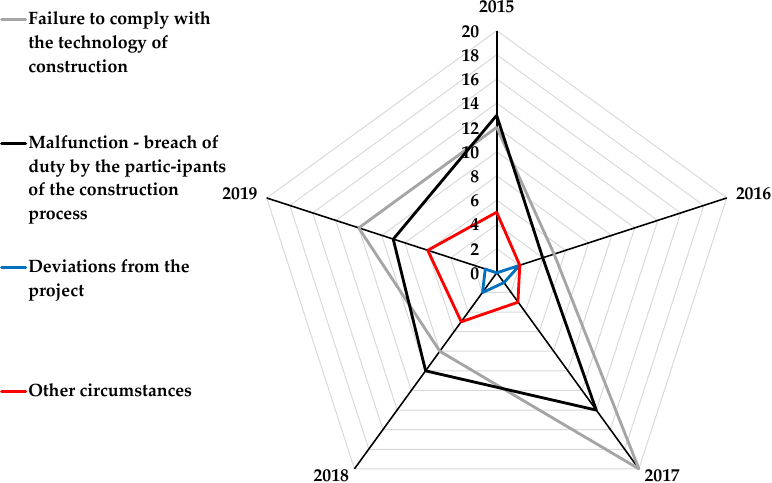
Figure 8. Structure of the causes of the structural failures during construction of a new facility or performing other construction works in an existing facility (own study).